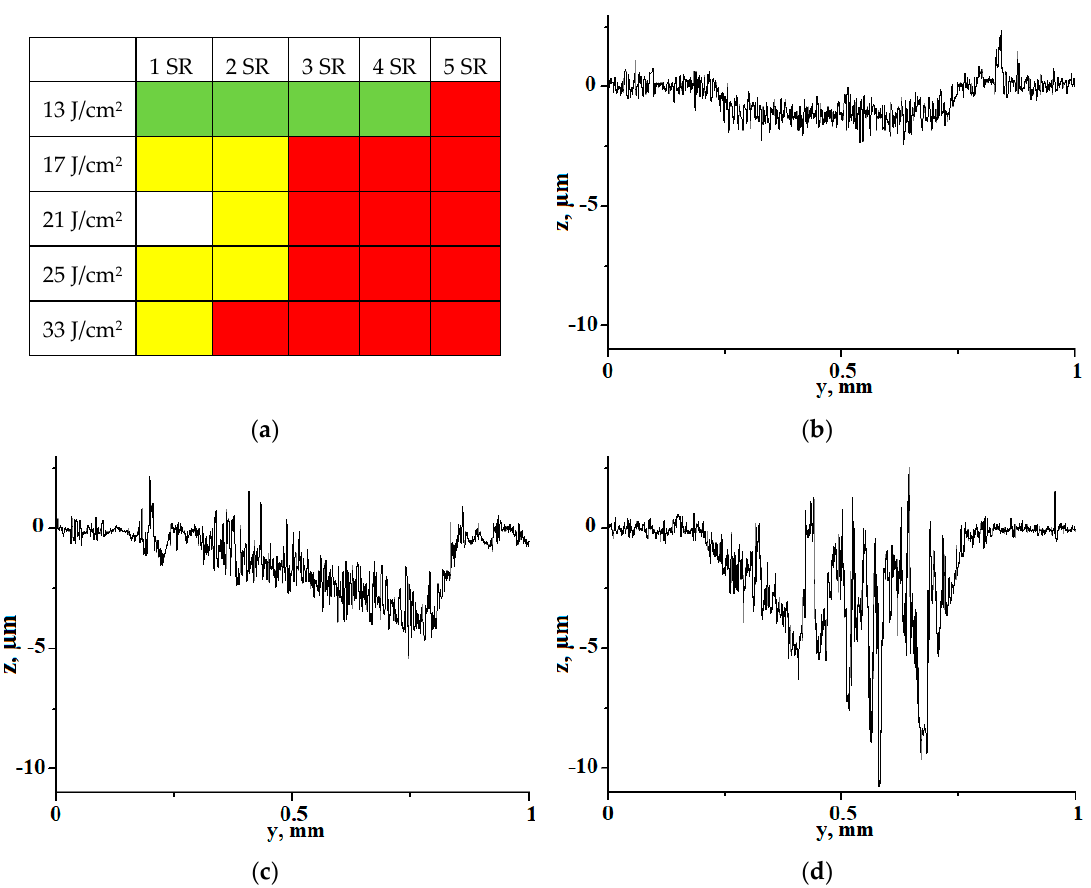
Figure 3. Profiles of laser-treated areas: ( a ) color-coded chart; ( b ) example profile for “green” profiles which are parallel to the initil surface; ( c ) example profile for “yellow” profiles with an observable slope; ( d ) example profile for “red” profiles with high roughness. SR: scan repetition.